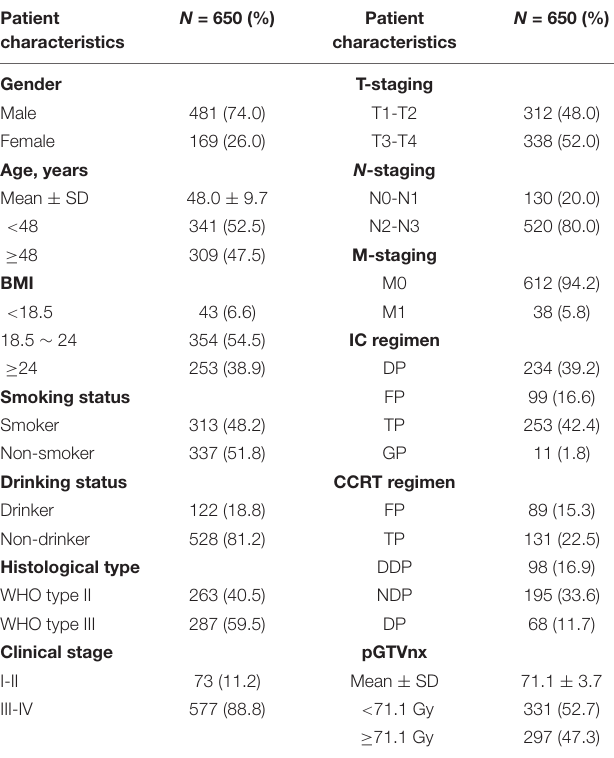
TABLE 2 | The clinical and treatment information of NPC